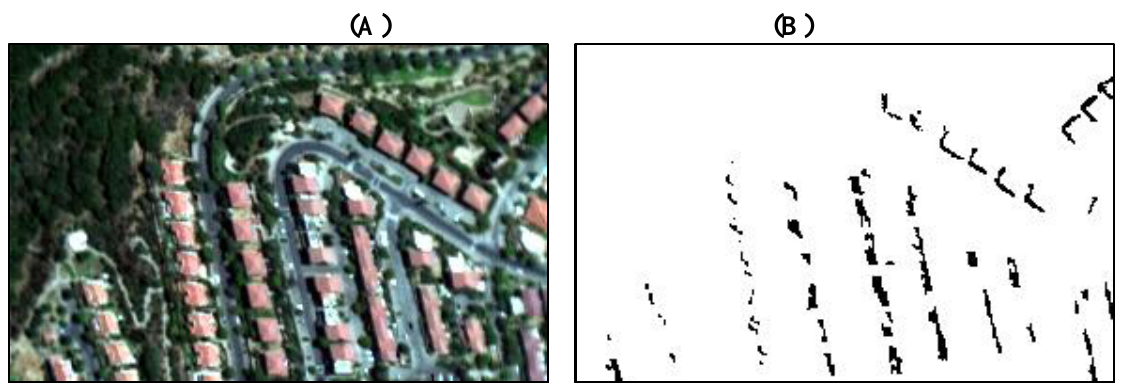
Figure 7. Shadow masks as generated from the original AISA-Dual image: ( A ) RGB natural color composite AISA-Dual image (09 Nov 2008; 09:00 GMT; 25 km visibility; midlatitude winter model; 30.8° solar zenith; 161° azimuth angle), ( B ) boresight shadow mask, ( C ) boresight shadow estimation (#4 (yellow) 10–20%, #3 (cyan) 20–50%, #2 (magenta) 50–80% and #1 (maroon) 80–100%), ( D ) ATCOR-4 shadow